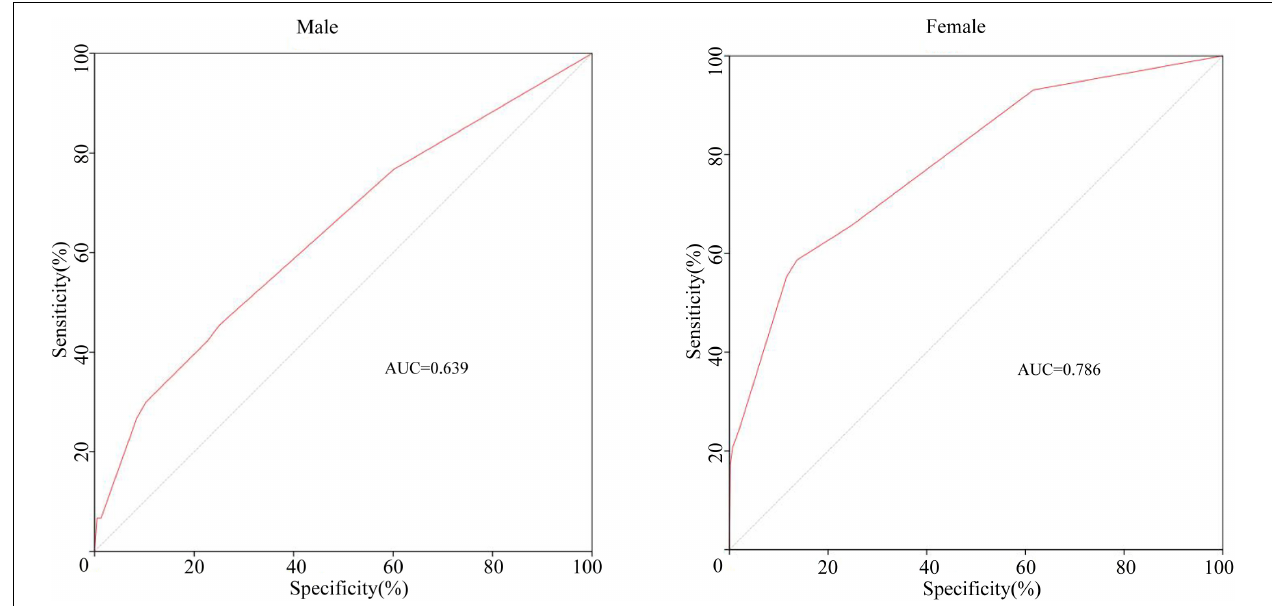
FIGURE 6 | The ROC curves of the combining symptoms (rash, oral changes, and cervical lymphadenopathy) classified by sex for predicting CAA.